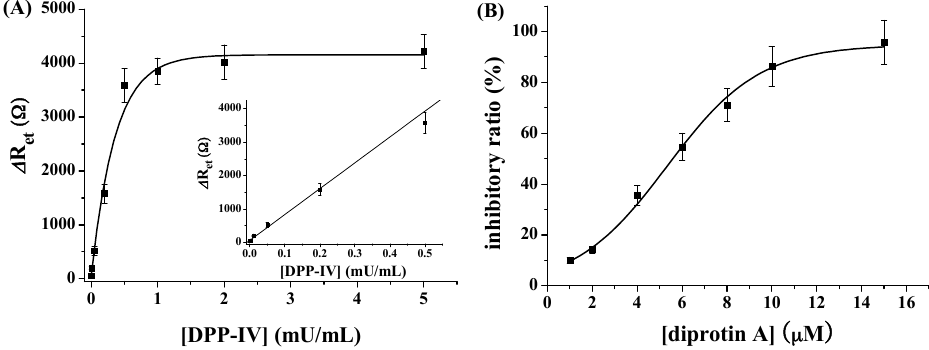
Figure 6. ( A ) Dependence of Δ R et on DPP-IV concentration (0, 0.001, 0.01, 0.05, 0.2, 0.5, 1, 2 and 5 mU/mL); ( B ) Inhibitory ratio of different concentrations of diprotin A (1, 2, 4, 6, 8, 10 and 15 μ M) on the DPP-IV (0.5 mU/mL) activity.